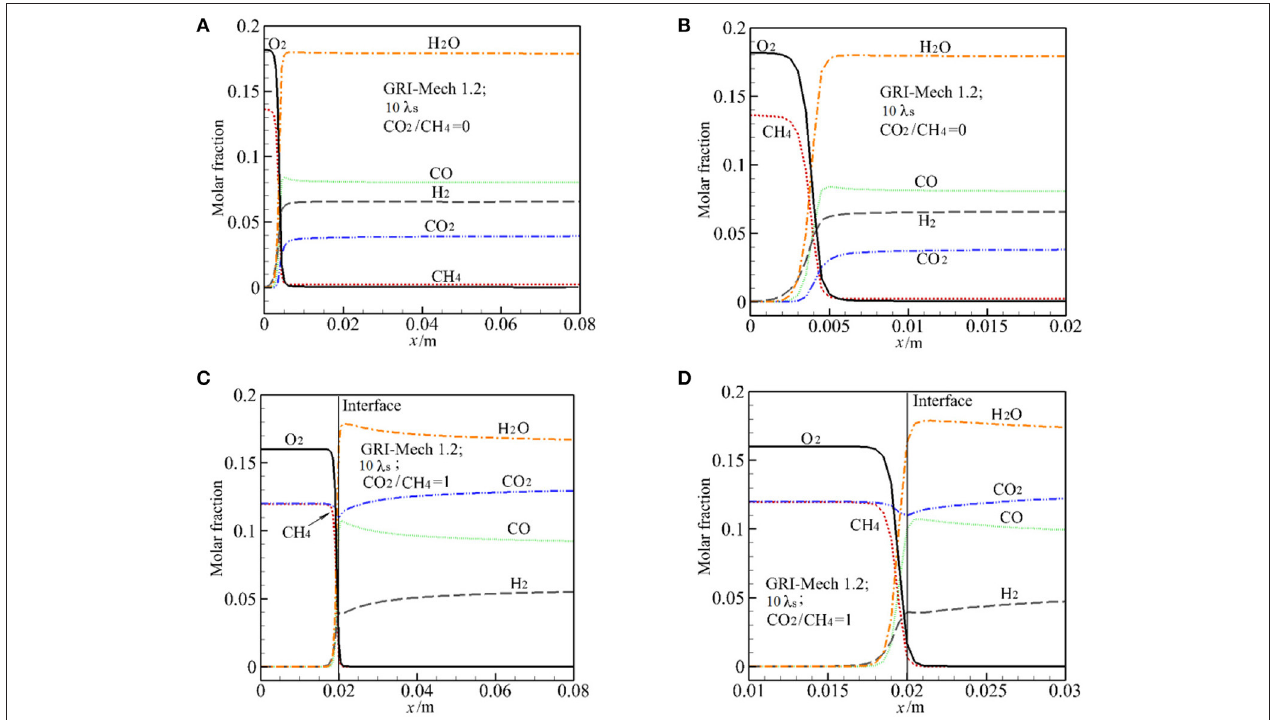
FIGURE 4 | Distribution of major species (molar fraction) by GRI-Mech 1.2 along the centerline and near the reaction zone for molar ratio of CO 2 /CH 4 = 0 and 1 at 10 times of thermal conductivity of packed bed. (A) Molar fraction of major species for CO 2 /CH 4 = 0; (B) Molar fraction of major species at the reaction zone for CO 2 /CH 4 = 0; (C) Molar fraction of major species for CO 2 /CH 4 = 1; (D) Molar fraction of major species at the reaction zone for CO 2 /CH 4 =